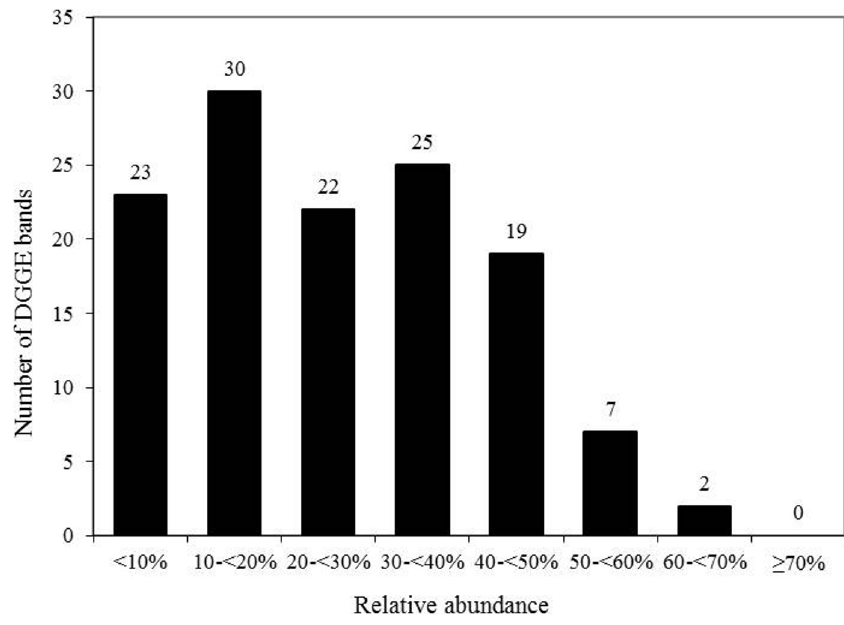
Figure 3. Relative abundance of DGGE-bands in human faecal samples from examinations before intervention periods. doi:10.1371/journal.pone.0109606.g003 Factor 1 was inversely associated with BMI, weight, and waist circumference and positively correlated with sex. Factor 2 was In this crossover intervention study, we investigated the inversely associated with BMI only, and factor 4 was positively isocaloric exchange of RM with WG products for a direct correlated with sex and negatively with BMI. None of these influence on gut microbiota composition. For each diet, we associations persisted after adjustment for sex (Table 4). Table 3. Changes in microbiota due to intervention in all participants; shown are bands with a significant change (0 R 1: band is absent before and present after intervention; 1 R 0: vice versa); # p Value of McNemar test.